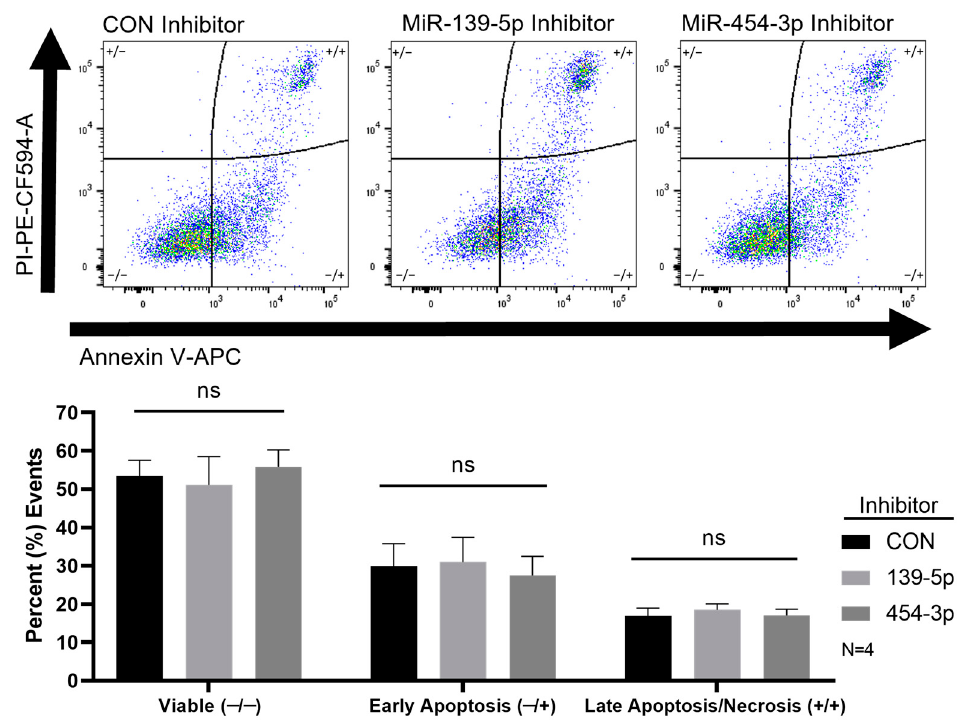
Figure 5. Annexin V and PI staining of HUVECs assessed by flow cytometry. The upper panel shows representative dot plots of Annexin V and PI staining of different groups of cells. No significant differences in the percent of cellular events were found for HUVEC viability, early apoptosis and late apoptosis/necrosis with miR-139-5p or miR-454-3p inhibition compared with negative control inhibitors (lower panel, N = 4). ns: not significant.